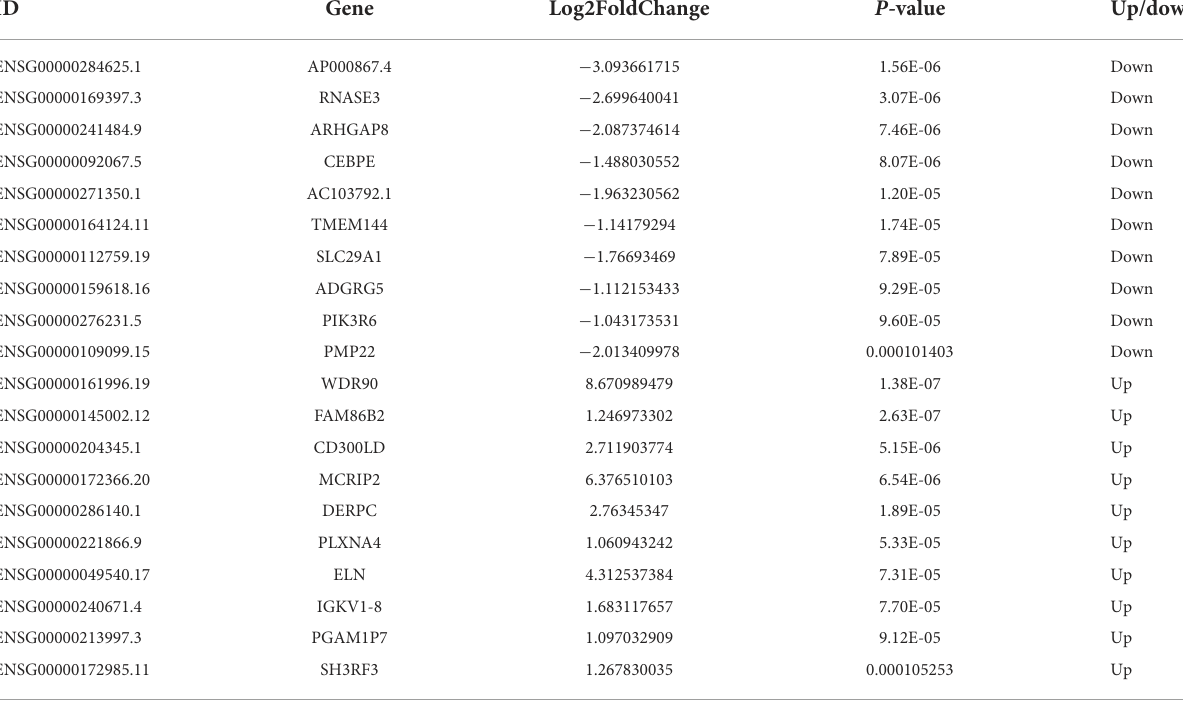
TABLE 2 Top 10 up/down-regulated DEmRNAs.